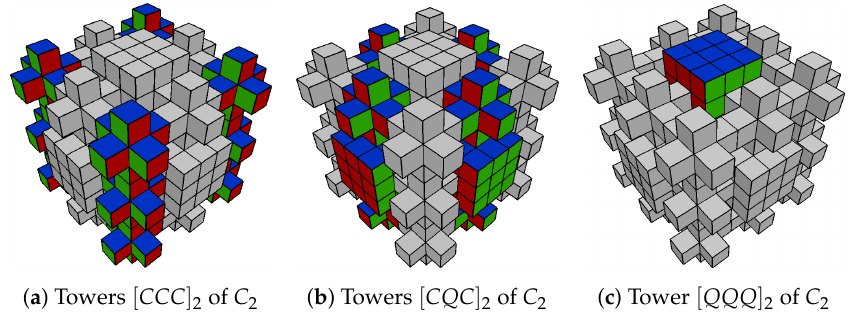
Figure 11. C 2 as a polycube composed by towers [ CCC ] 2 , [ CQC ] 2 and [ QQQ ] 2